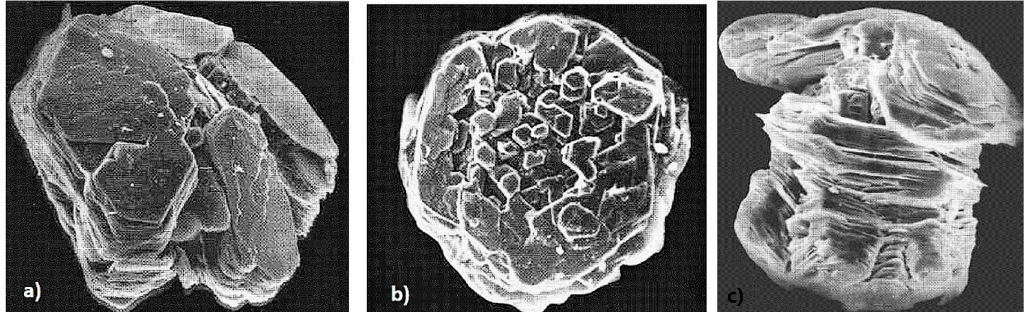
Figure 35. Some forms of metamorphic graphite: ( a ) Splitting of the crystal into separate pinacoidal or pinacoidal-prismatic blocks; ( b ) early spherical graphite aggregate; ( c ) columnar graphite; reproduced from [47] with permission from Canadian Mineralogist.